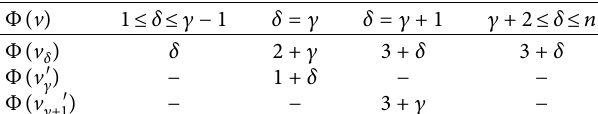
Table 5: Vertex labeling of Φ ( v ).